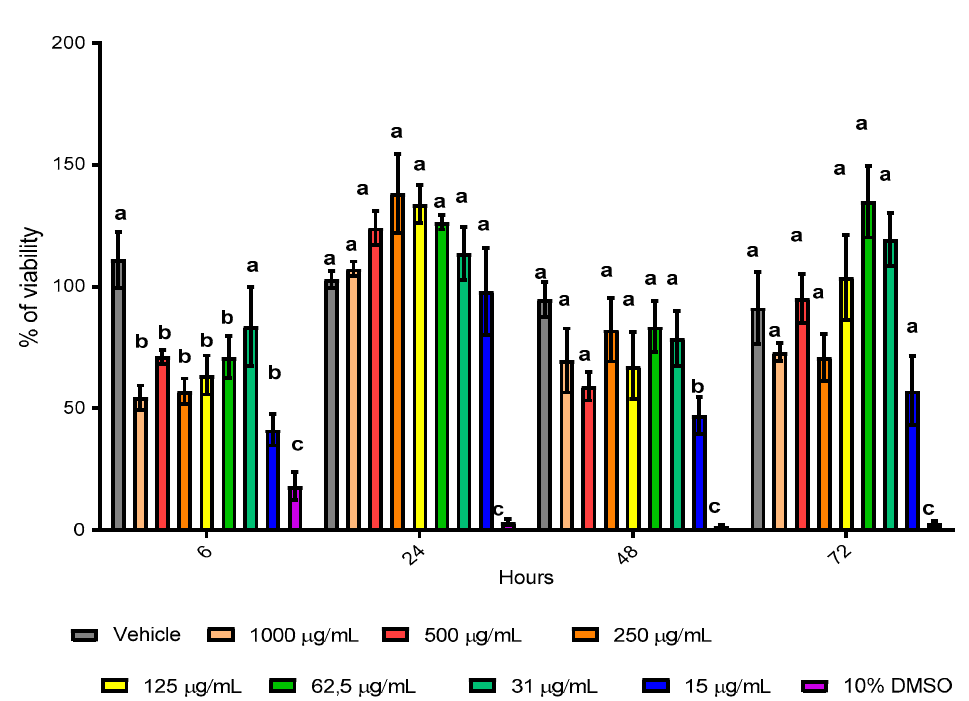
Figure 5. Effect of biomass in HaCaT skin cell line evaluated by MTT assay. The figure shows HaCaT cells cultivated with biomass of the strains Halorubrum tebenquichense Te Se-86 for 6, 24, 48 and 72 h of stimulus. The stimulus was evaluated as a percentage of viability with respect to the vehicle. Serial dilutions from 1000 to 15 µg/mL were incubated. Three independent experiments were performed. Bars indicate mean ± SD. Equal letters are not significative differences; different letters show a significative difference. p < 0.05, using a Kruskal–Wallis statistics test.